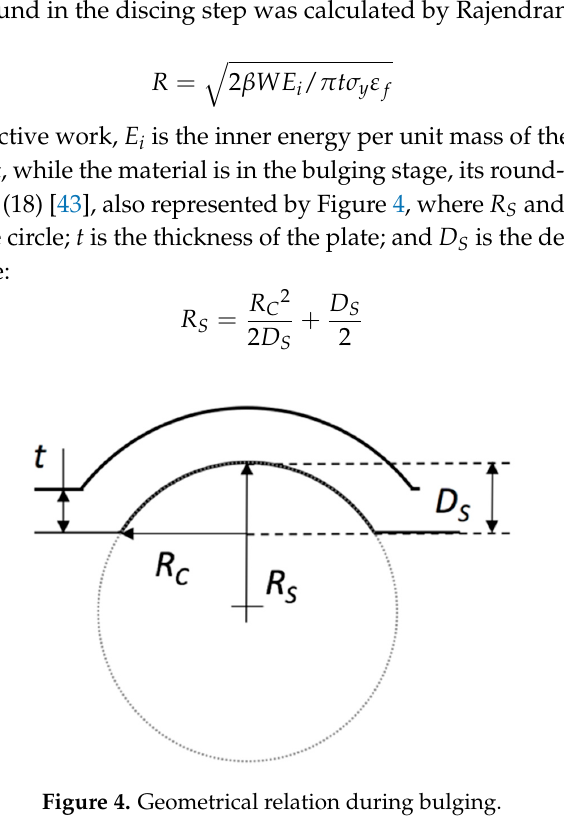
Figure 4. Geometrical relation during bulging.